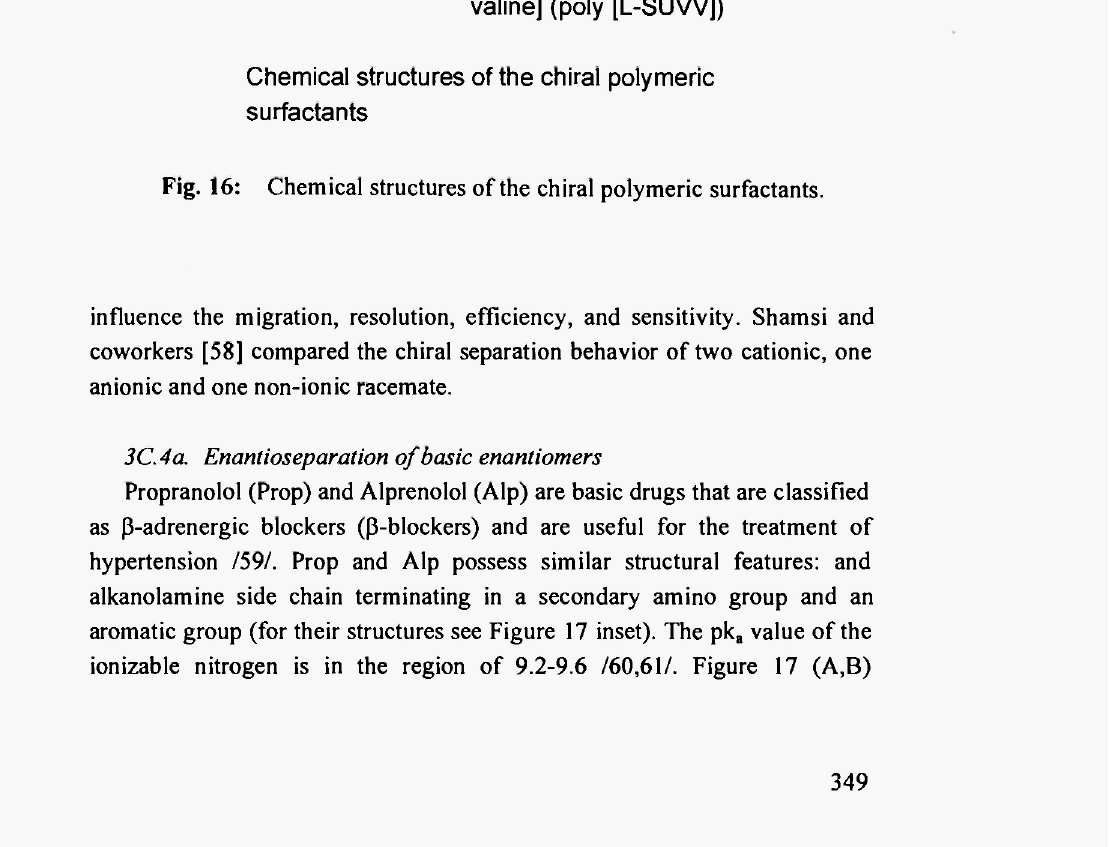
Fig. 16: Chemical structures of the chiral polymeric surfactants.